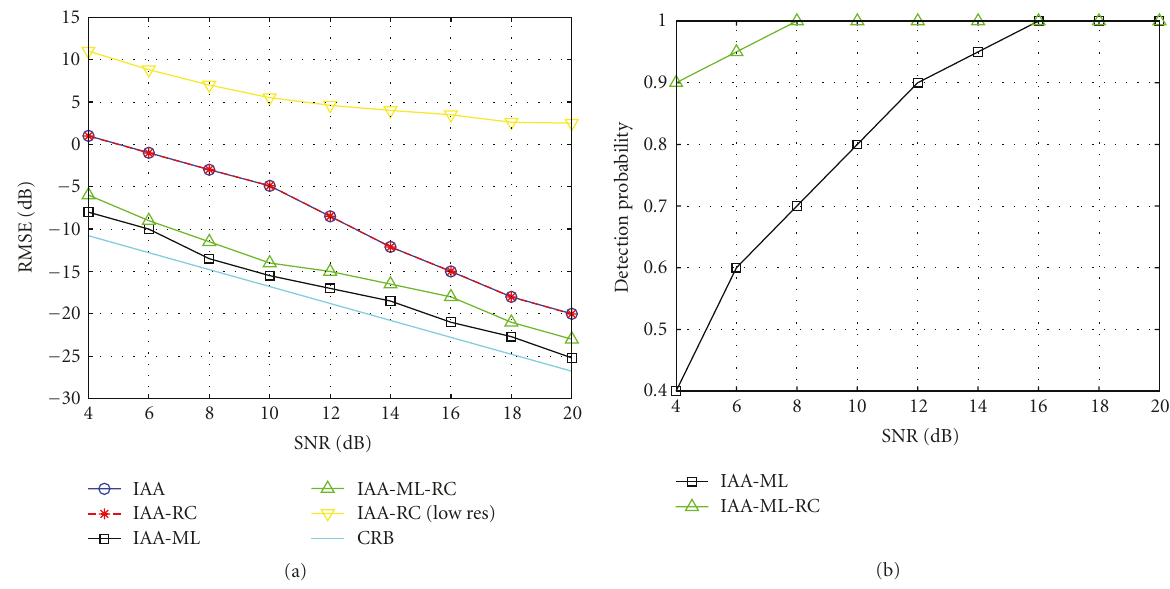
Figure 9: (a) RMSE of the di ff erent beamforming solutions. (b) IAA-ML versus IAA-ML-RC detection probability (rectangular array, θ 1 = 45 ◦ , φ 1 = 150 ◦ , θ 2 = 45 ◦ , φ 2 = 188 ◦ , θ 3 = 45 ◦ , φ 3 = 250 ◦ , N = 10 snapshots, noise power equal to 0dB, and f c = 1575MHz).